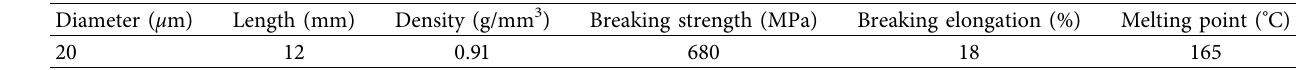
Table 2: The properties of